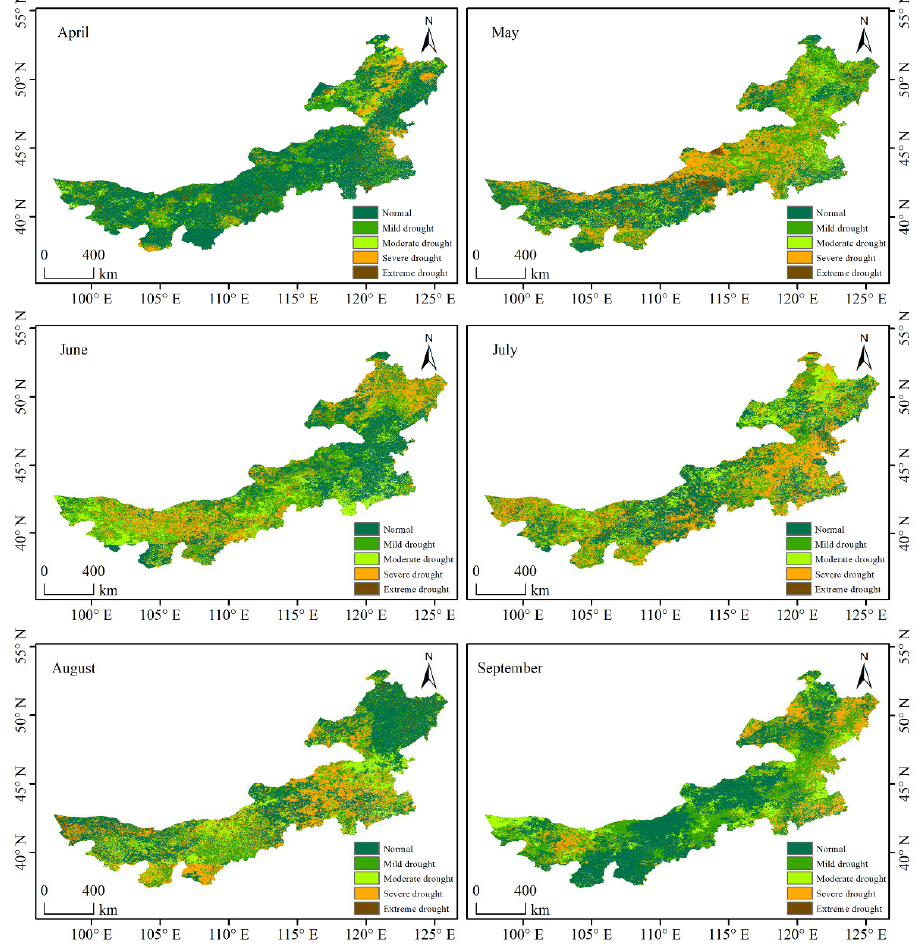
Figure 5. Monitoring results of the drought model during the growing season in 2015.